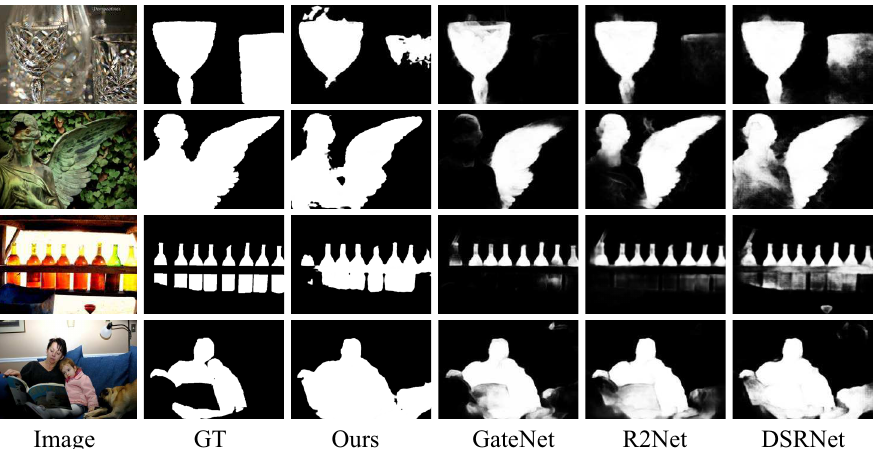
Figure 9. Failure cases of the proposed GSCINet method and other state-of-the-art SOD methods, including GateNet [22], R2Net [21] and DSRNet